Question: In a single sentence, describe what this figure presents.
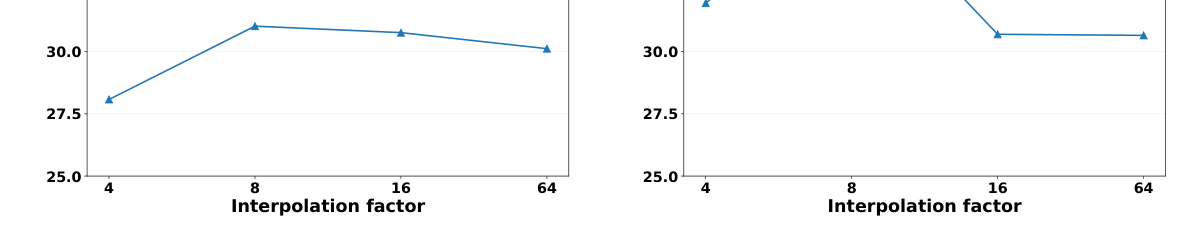
Answer: Median PSNR values for reconstructions of slices from the LIDC test set given : 9, 23 and 50 experimental viewing angles. They are obtained with cGLO without any training dataset (left) and trained on the 35% portion of the LIDC dataset (right).